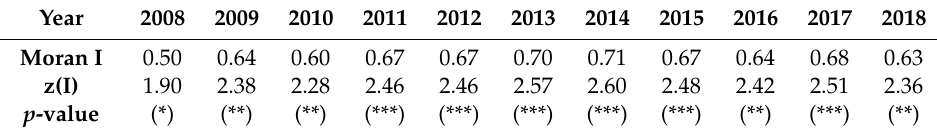
Table 2. Spatial autocorrelation of Asthma Emergency Visits (AEV).